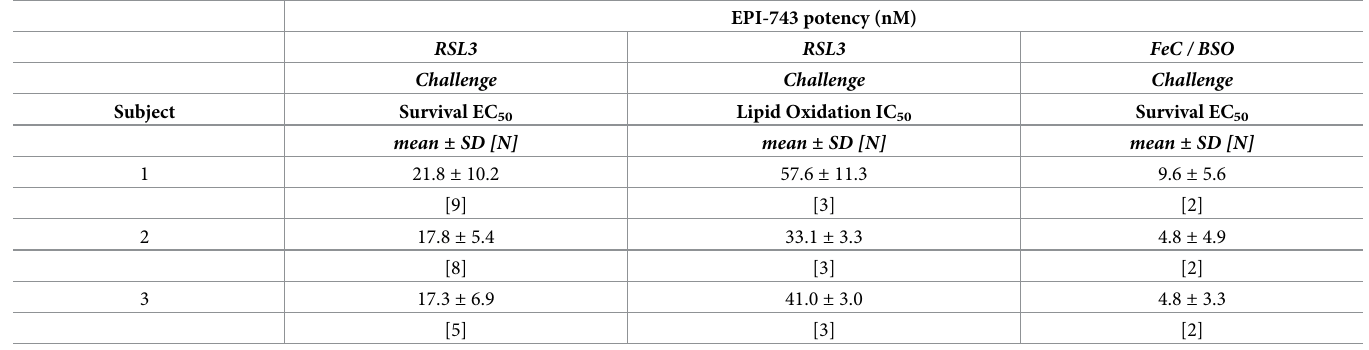
Table 2. Summary of EPI-743 rescue potencies in PCH6 patient